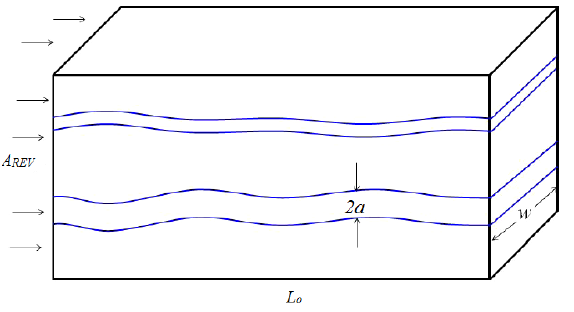
Figure 1. Schematic view of a fractured medium composed of a bunch of parallel